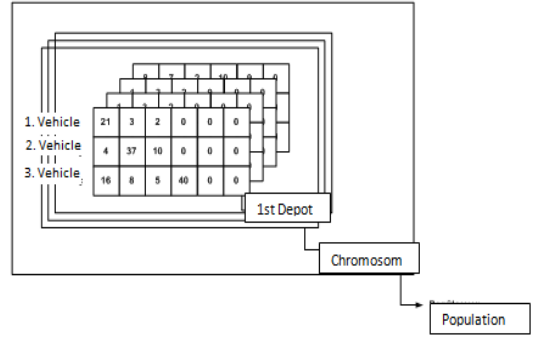
Figure 1: Population representation of multi depot ARP and CPP problems in